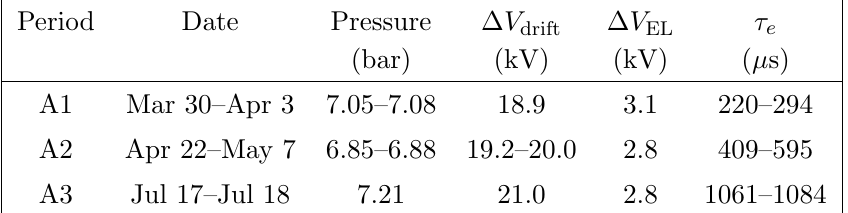
Table 1 . Detector operating conditions during the NEXT-White Run-II alpha runs. The dates refer to the 2017 calendar year. The voltage drops across the drift and EL regions are given by (cid:1) V drift and (cid:1) V EL , respectively. The column (cid:28) e indicates the range of electron lifetimes